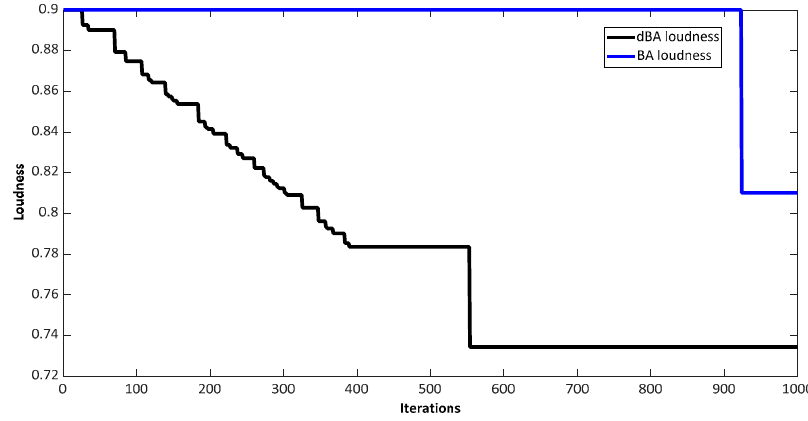
Figure 8. The pulse rate of the best bat of the BA and dBA.